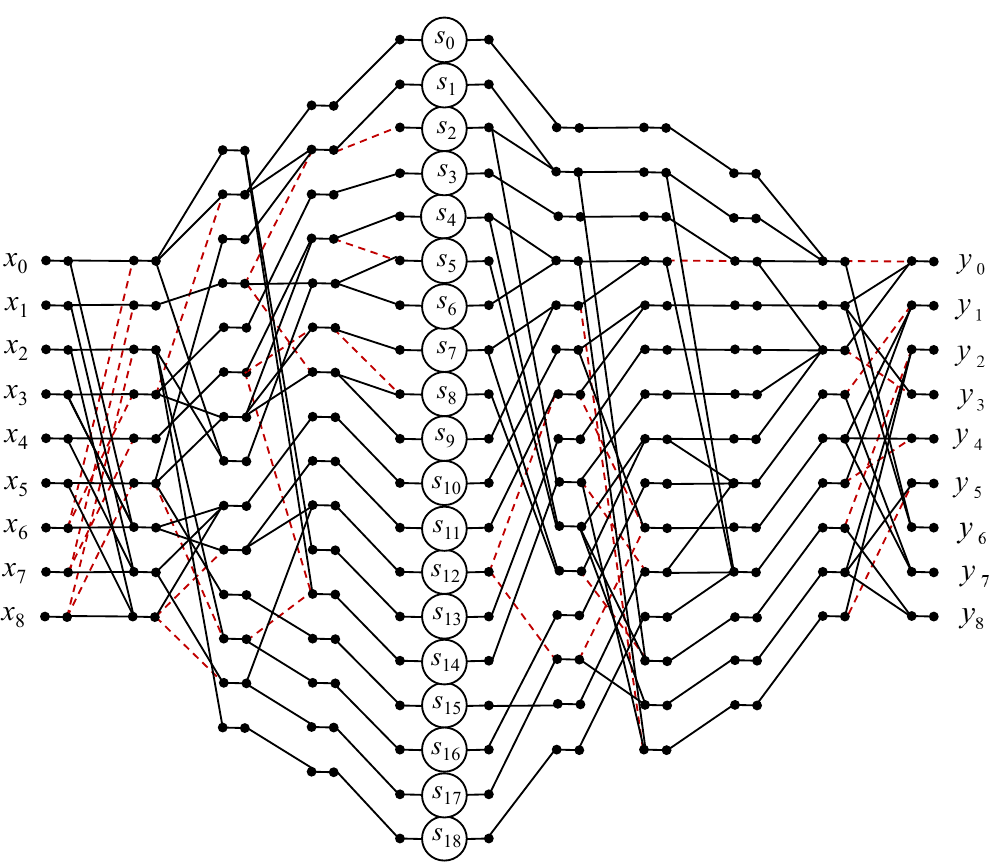
Figure 8. Algorithmic structure of the processing core for the computation of the 9-point circular